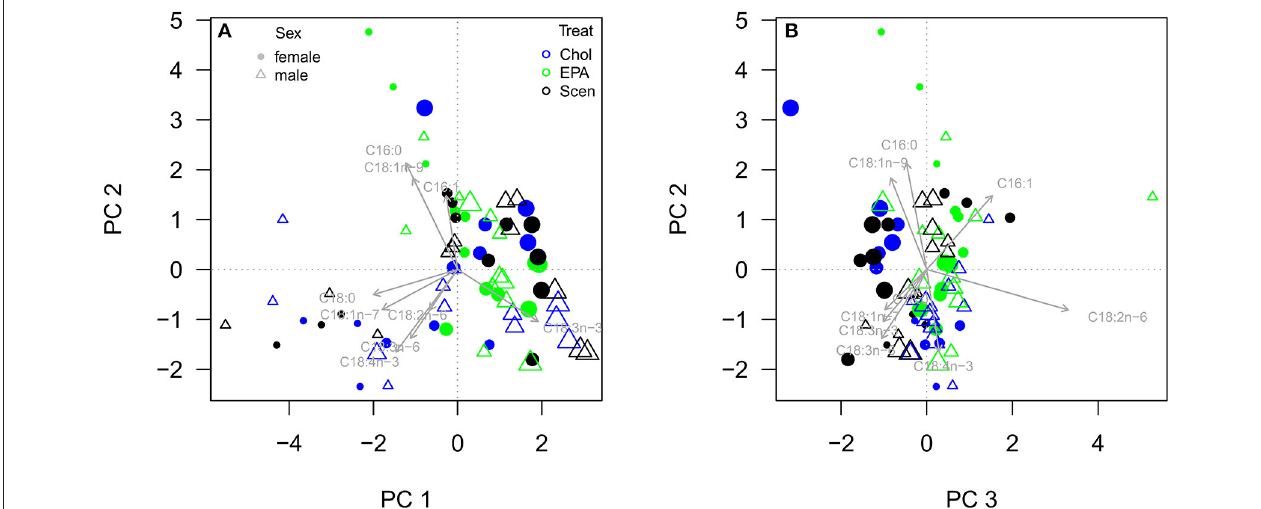
FIGURE 7 | Principal component analysis (PCA) of the fatty acid profiles of egg-bearing female (filled circles) and male (triangles) D. magna reared on S. obliquus (Scen) supplemented with cholesterol- (Chol) or EPA-containing liposomes (EPA). PC1, PC2 (A) , and PC3 (B) explained 39.7, 21.4, and 11.9% of variation, respectively. The PCA was calculated using fatty acid proportions of total fatty acids without considering EPA, which was detected only after supplementation in low concentrations. Female data represent fatty acids detected in somatic tissue and eggs of the respective clutch. The four consecutive sampling events are exemplified by increasing symbol sizes, i.e., the first sampling at day four is represented by the smallest symbols and the last sampling at the third reproduction cycle is represented by the largest